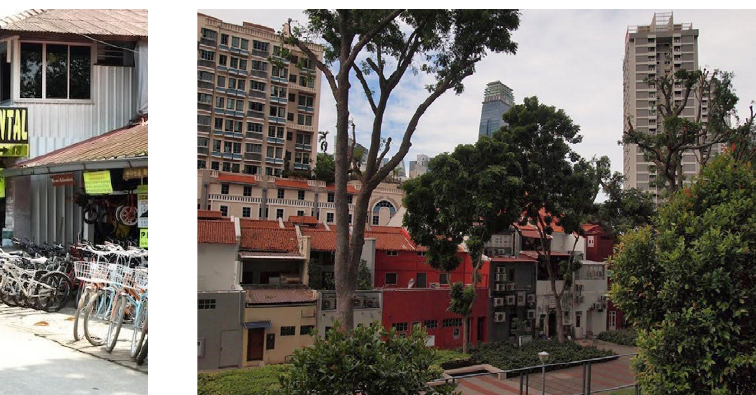
Figure 5. Pulau Ubin – Singapore Figure 6. Duxton Plain Park –